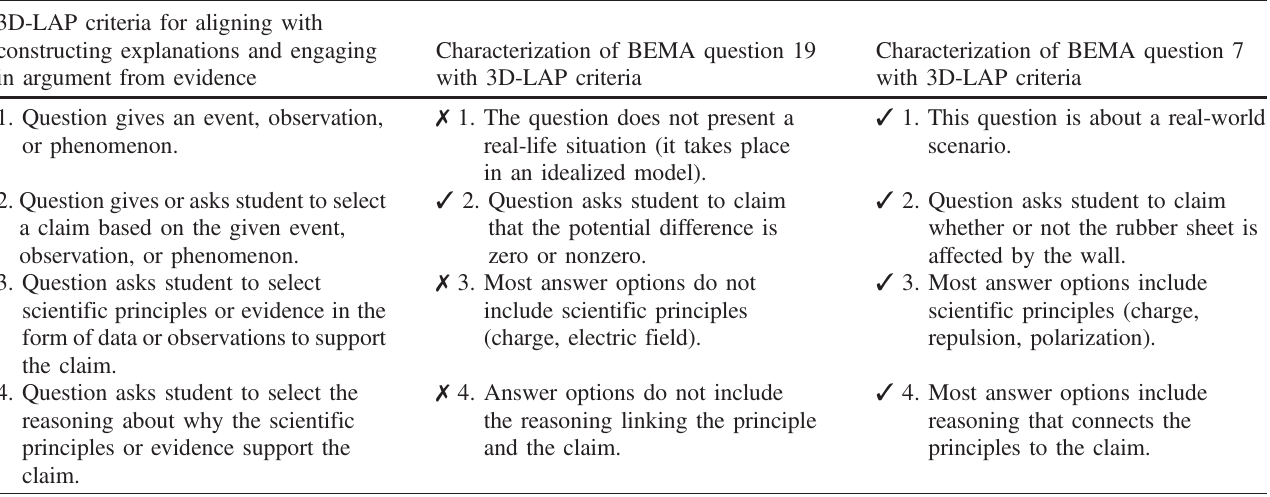
TABLE I. An analysis of question 19 and question 7 of the BEMA using the 3D-LAP criteria for the scientific practice of constructing explanations and engaging in argument from evidence. An assessment task must meet all of the criteria in order for it to be considered to elicit that